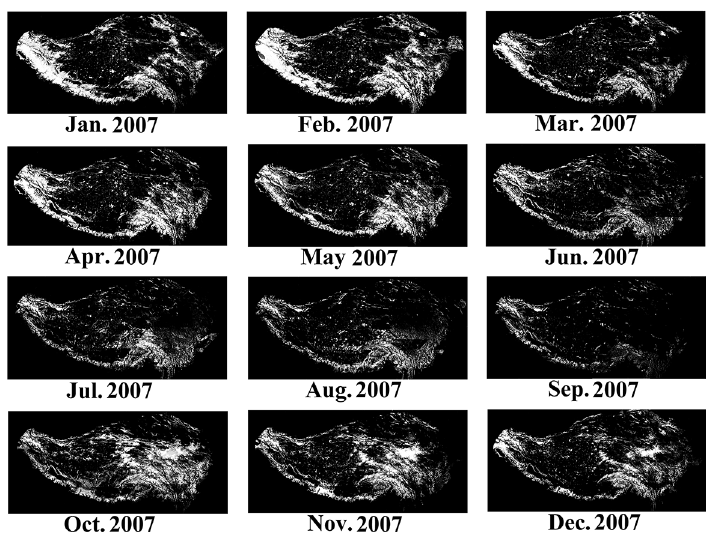
Figure 18. Monthly fractional snow cover of Qinghai–Tibet Plateau in 2007.